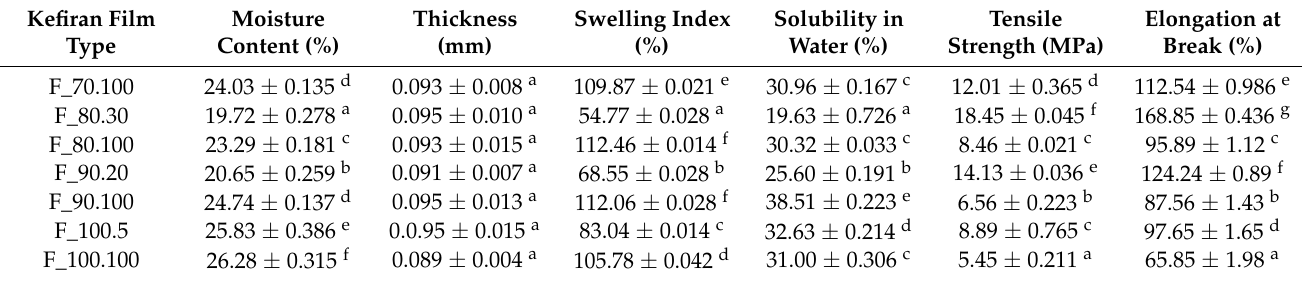
Table 1. Values of moisture content, thickness, swelling index, water solubility and mechanical properties of films. Kefiran